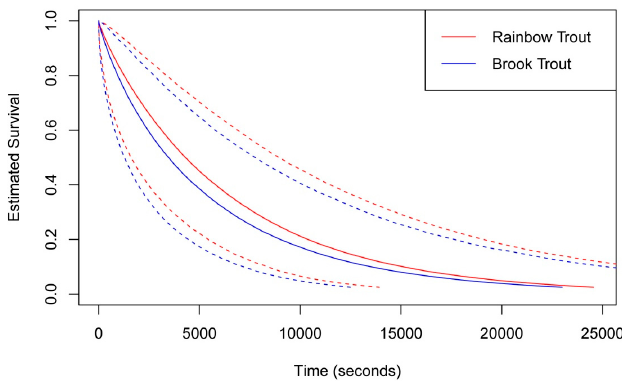
Figure 2. Survival analysis curve showing the fate of brown ( Salvelinus fontinalis ) and rainbow trout ( Oncorhychus mykiss ) carcasses over the course of the experiment. Rainbow trout estimated survival (persistence of carcass) is shown in red and Brook trout is shown in blue. Dotted lines indicate standard errors around the fit line for the estimated survival of species.